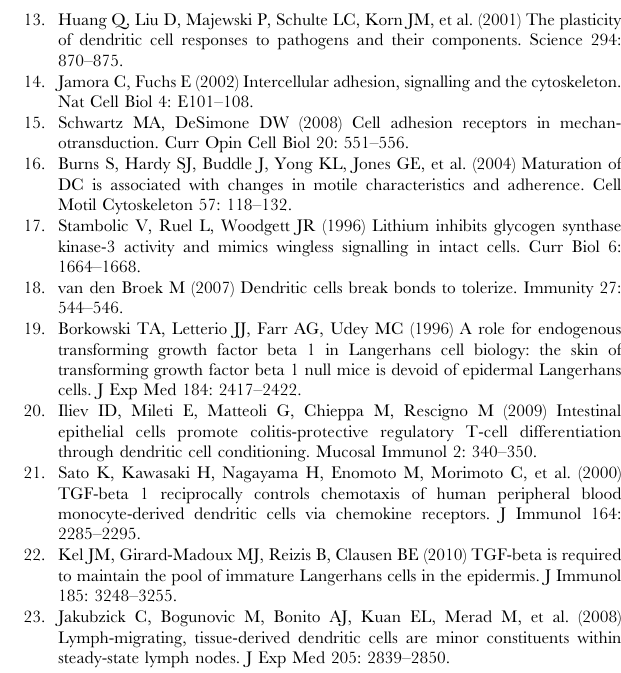
Figure S3 Lentiviral shRNA knockdowns in BMDCs.